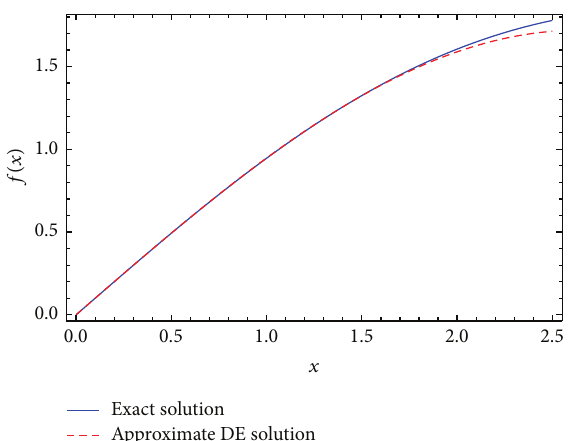
Figure 3: Approximate solution for (𝑥 2 + 1)𝑦 󸀠󸀠 − 2𝑥𝑦 − 𝑥 2 − 1 = 0 with 𝑦(0) = 0 and 𝑦 󸀠 (0) = 1